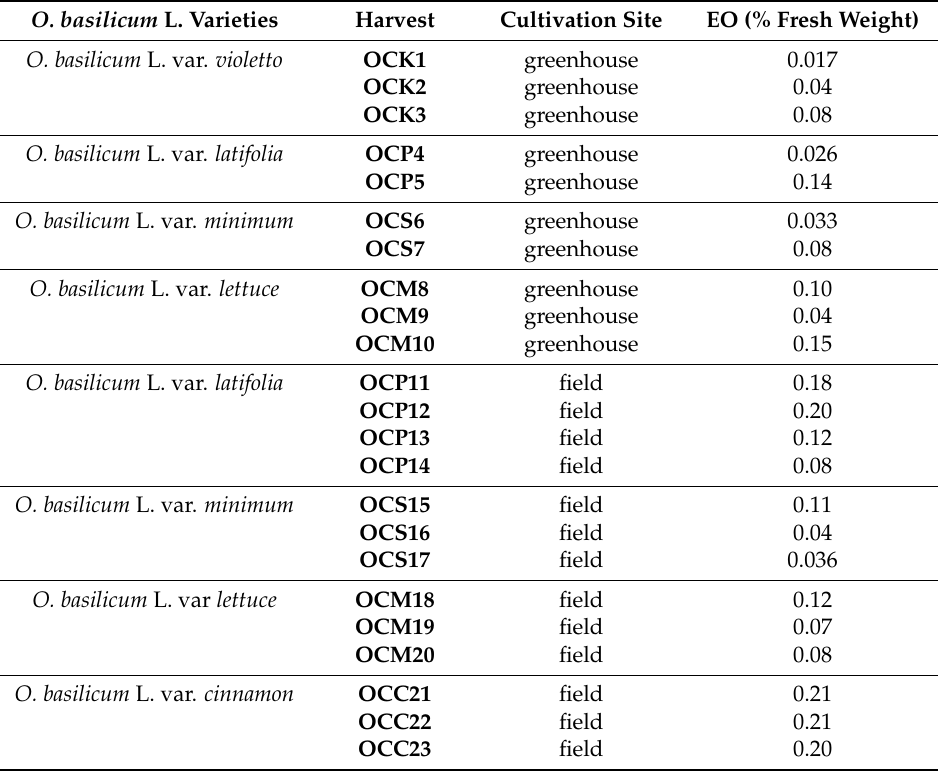
Table 1. Samples from O. basilicum varieties and essential oil